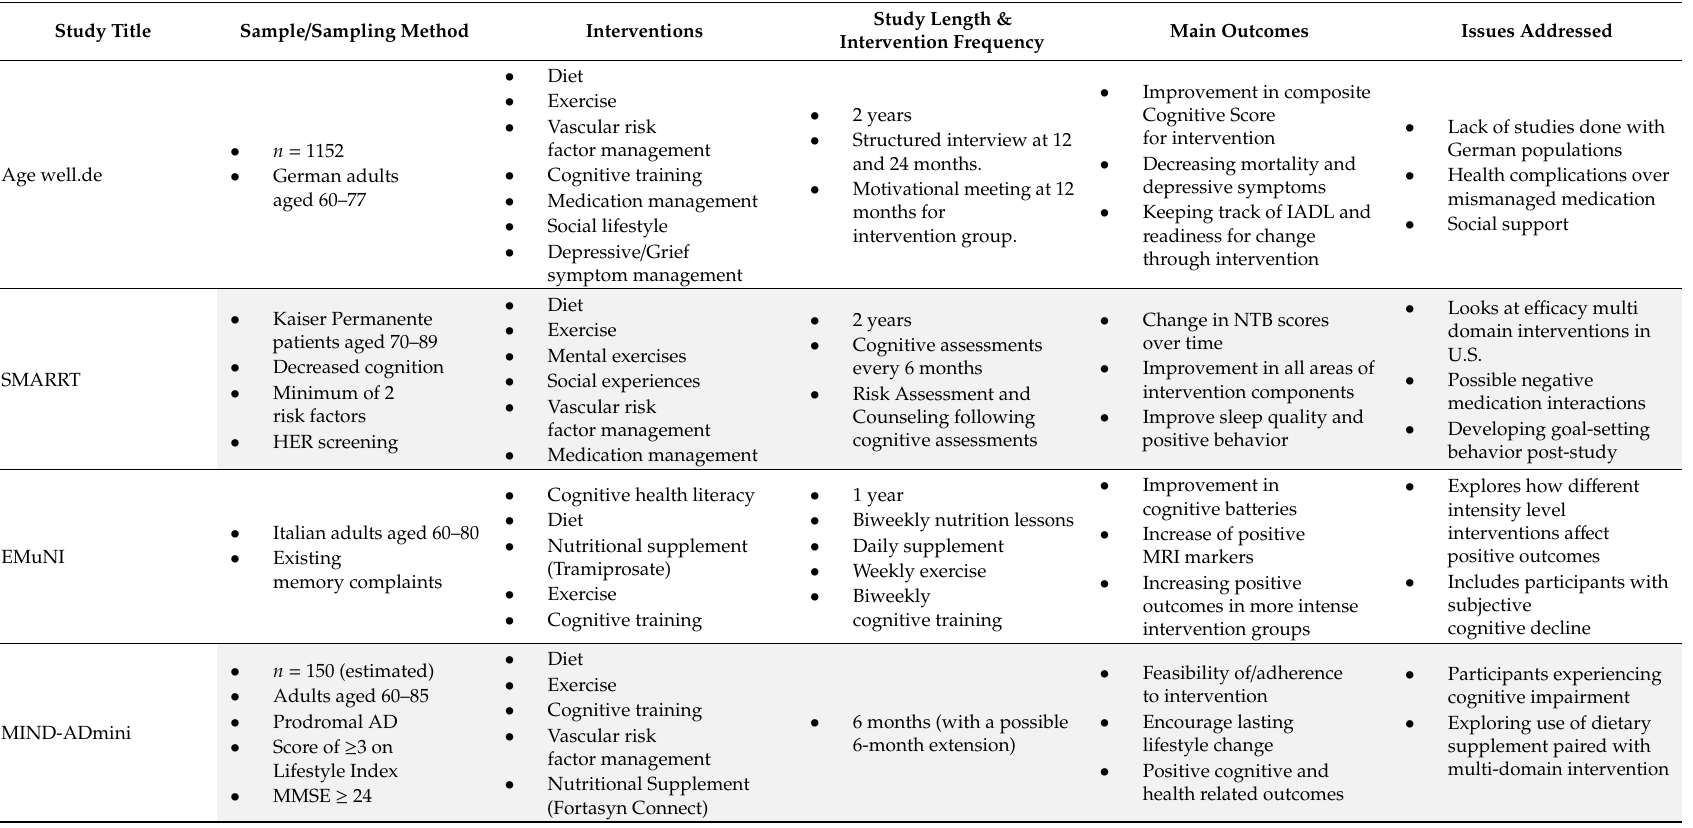
Table 2. On-going or prospective Face-to-Face multidomain interventions to enhance cognitive reserve and reduce risk of